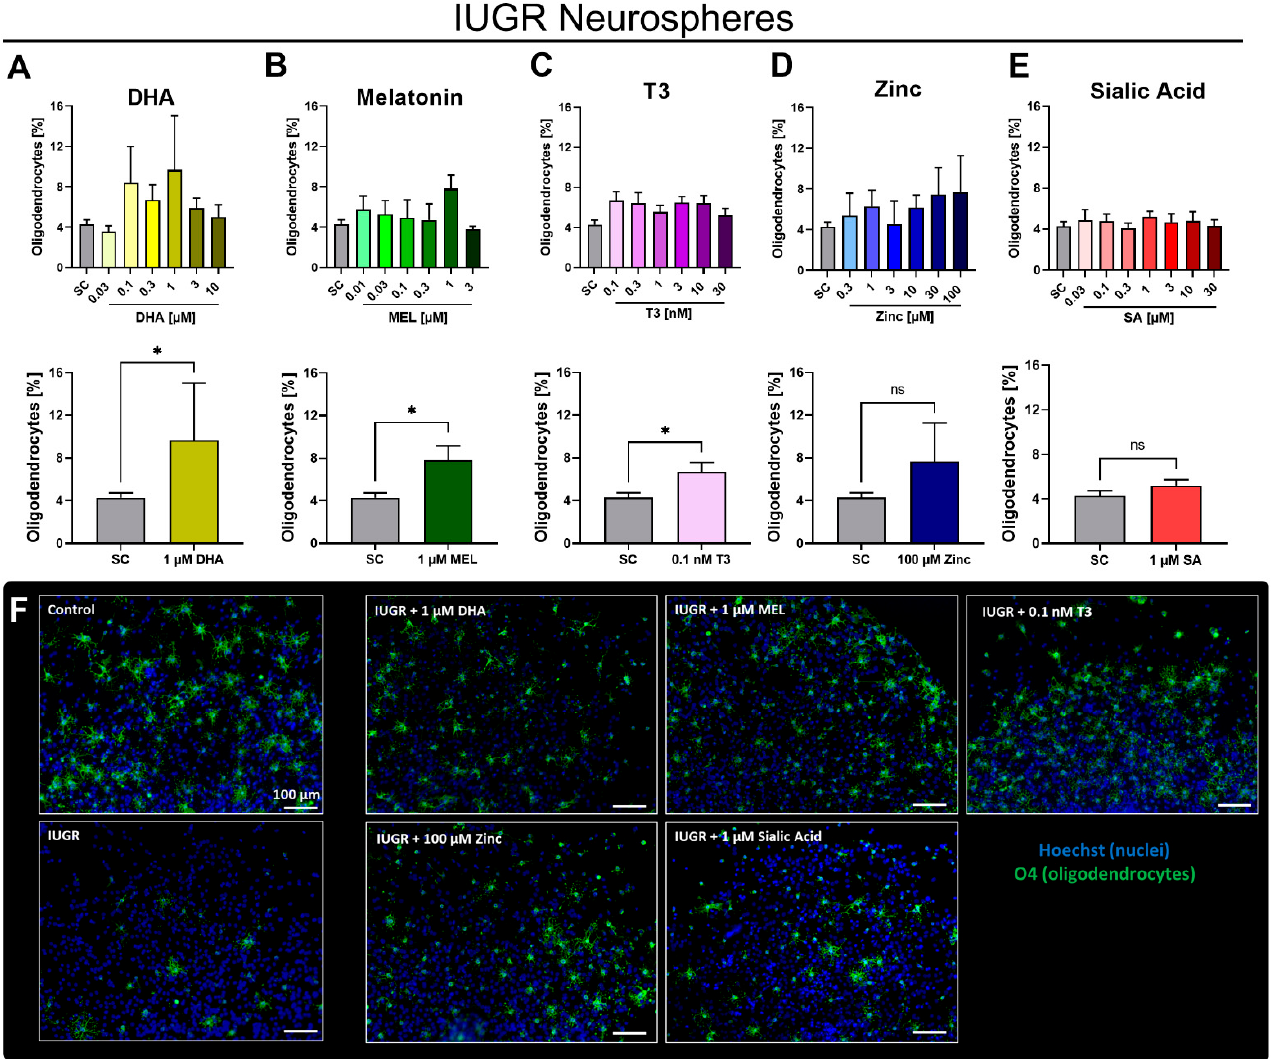
Figure 4. Effective concentrations of potential therapies in IUGR neurospheres. Rabbit neurospheres obtained from IUGR pups were cultured for 5 days and tested for oligodendrocyte percentage (mean ± SEM) with increasing concentrations (upper row) or the most effective concentration (lower row) of ( A ) DHA, ( B ) MEL, ( C ) zinc, ( D ) T3 and ( E ) SA. ( F ) Representative pictures of control and IUGR neurospheres; and of IUGR neurospheres exposed to the most effective concentration of DHA, MEL, T3, zinc and SA. Oligodendrocyte marker O4 (green) and Hoechst 33258 (blue), Scale bar = 100 µm. Analysis was evaluated in 5 neurospheres/condition in at least 3 independent experiments. ns: not significant, *: p < 0.05 vs. solvent control (SC).